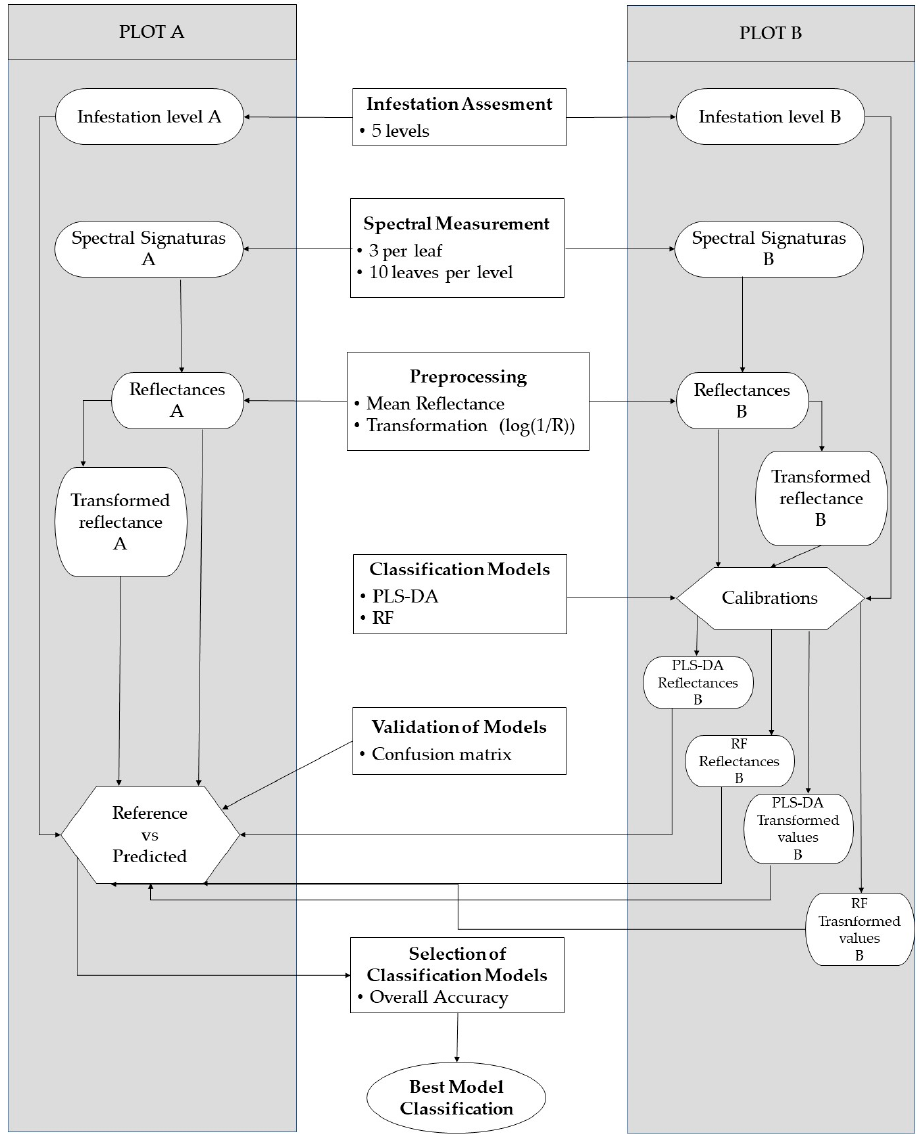
Figure 2. Workflow, as follows: 1. Infestation assessment; 2. Spectral measurements; 3. Spectral data preprocessing; 4. Classification model fittings; 5. Classification model validations; 6. Best classifier selection.